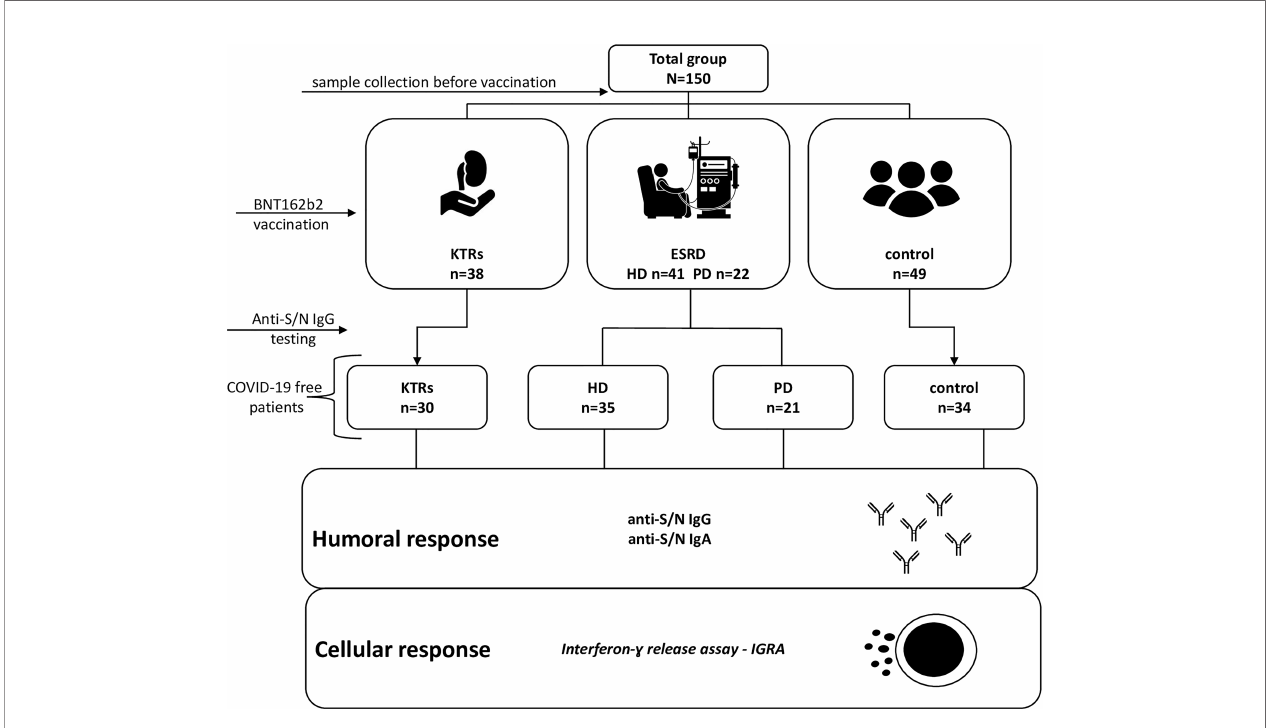
FIGURE 1 | Study cohort and the overall research